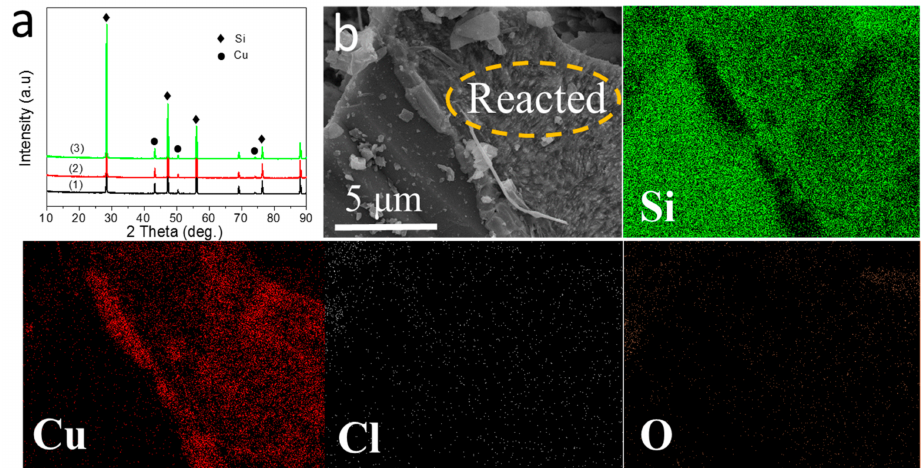
Figure 8. XRD patterns of contact masses after reaction: ( a ) (1) S-CuO, (2) H-CuO and (3) H-SnO 2 -CuO); ( b ) SEM image of the contact mass using H-SnO 2 -CuO catalysts after a 24 h reaction and the corresponding elemental mapping